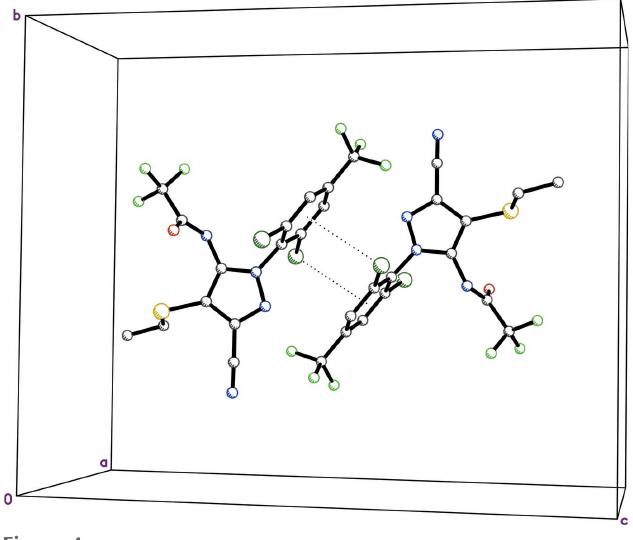
Figure 4 Pairs of inversion-related molecules in I showing mutual contacts between Cl and the benzene rings (dotted lines).